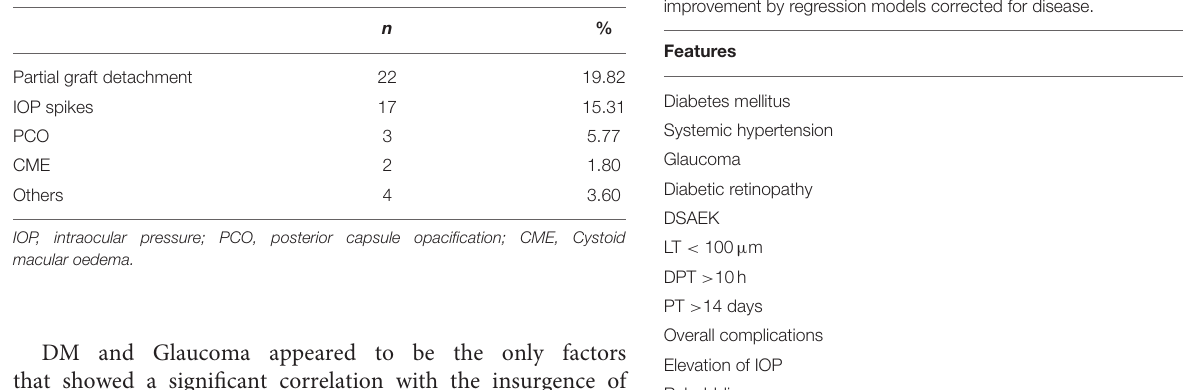
TABLE 4 | Post-operative complications.